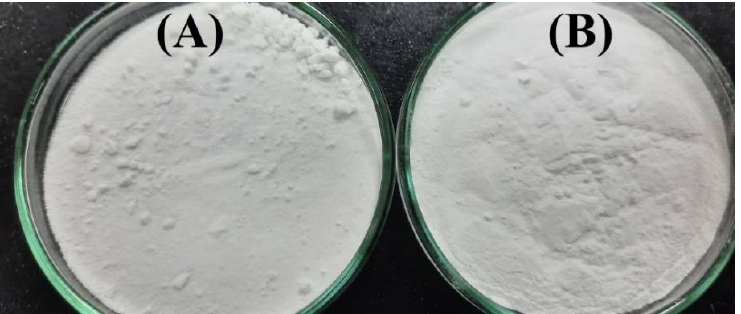
Figure 1. Physical appearance of formulations with increasing concentration of ( A ) MBA, and ( B ) ASPA/AMPS of ASPA-pAMPS microgels.